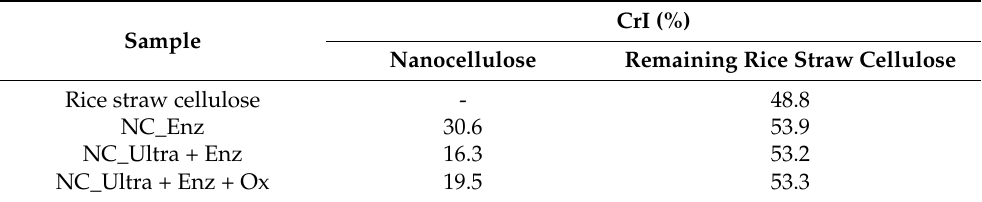
Table 5. The crystallinity index of rice straw nanocellulose and remaining rice straw cellulose from various integrated biobased